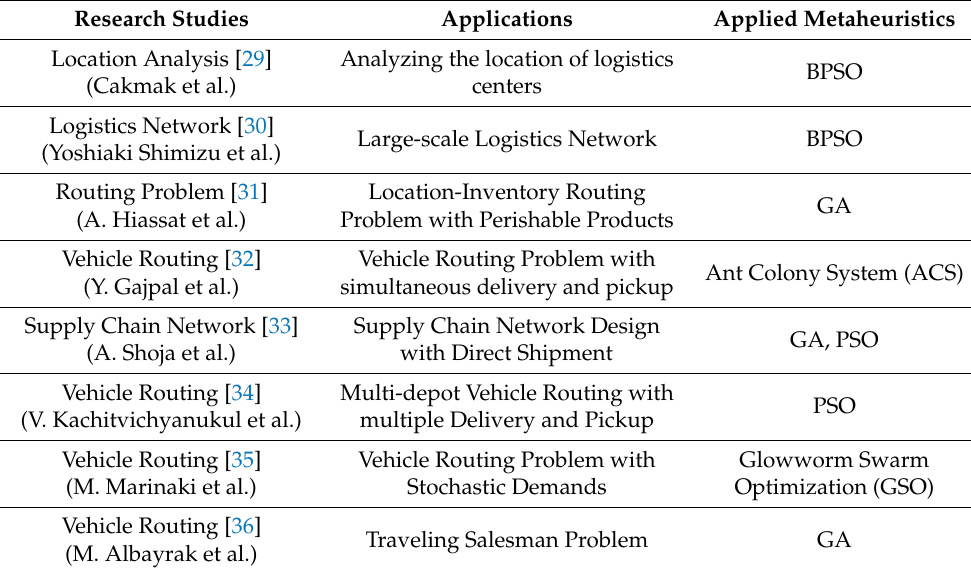
Table 1. Metaheuristic-based decision of logistic